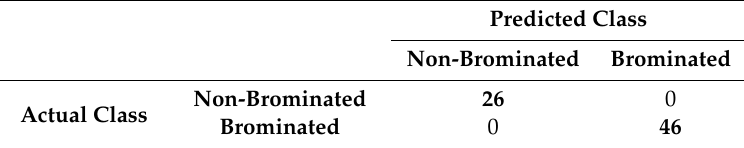
Table 3. Confusion matrix of the LDA model for the brominated and non-brominated